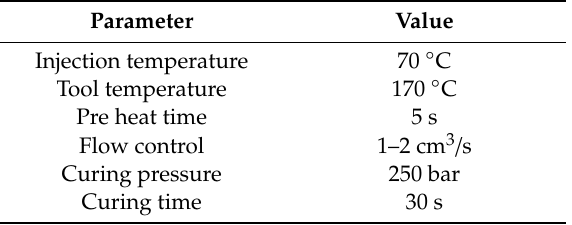
Table 2. Process parameters for the injection molding